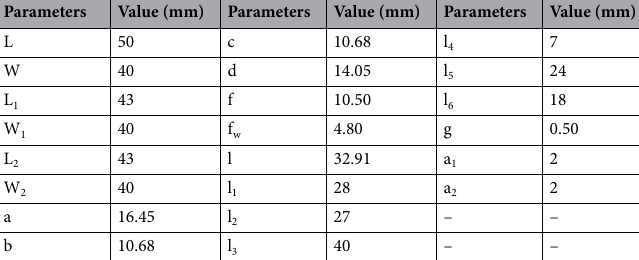
Table 1. The geometric parameters of the stacked